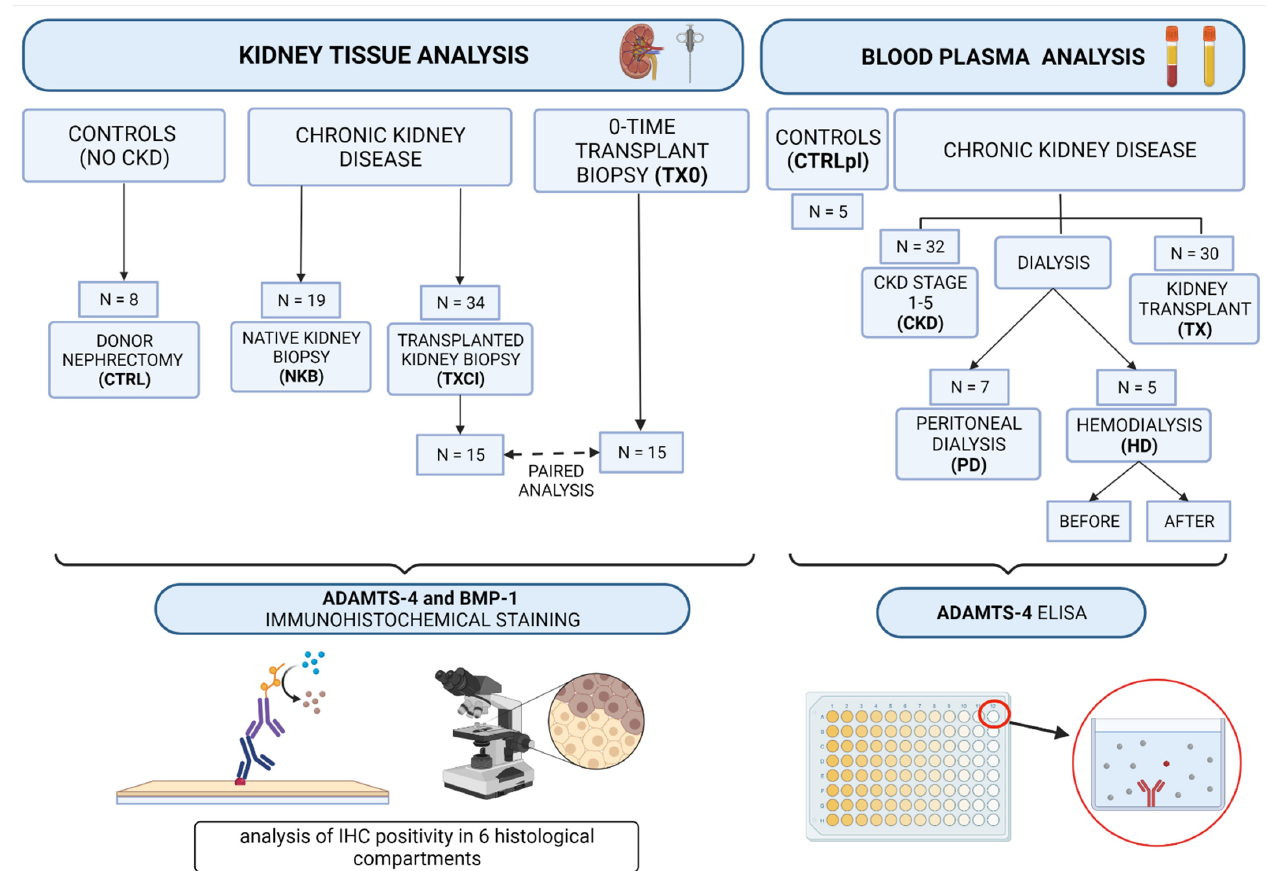
Figure 1. Study outline showing subject groups and the methodological approach.